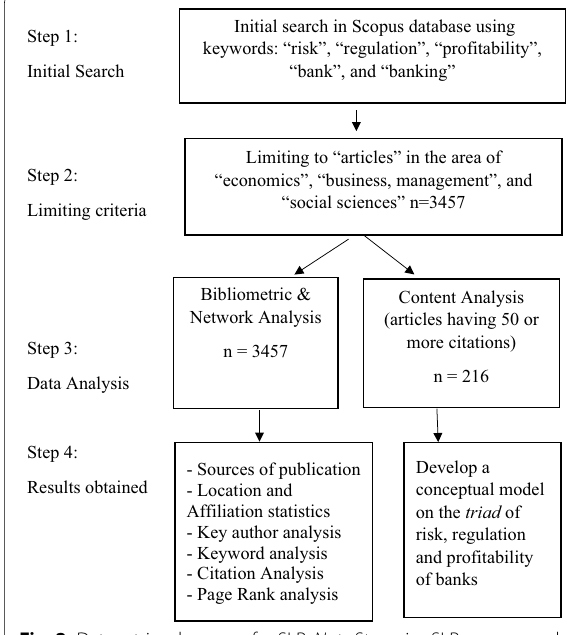
Fig. 2 Data retrieval process for SLR. Note Stepwise SLR process and corresponding results obtained